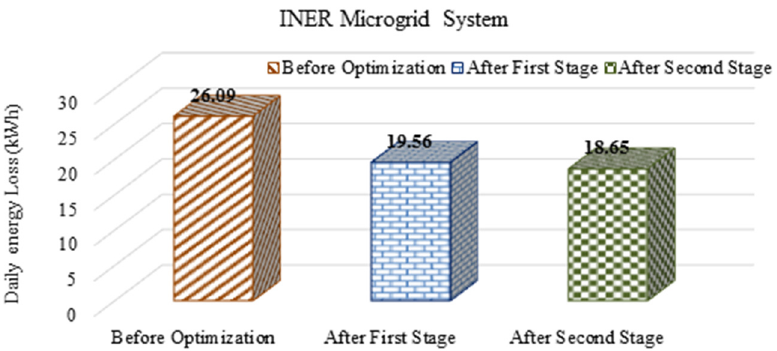
Figure 13. Simulation result of the daily energy loss of a weekday in summer of the INER